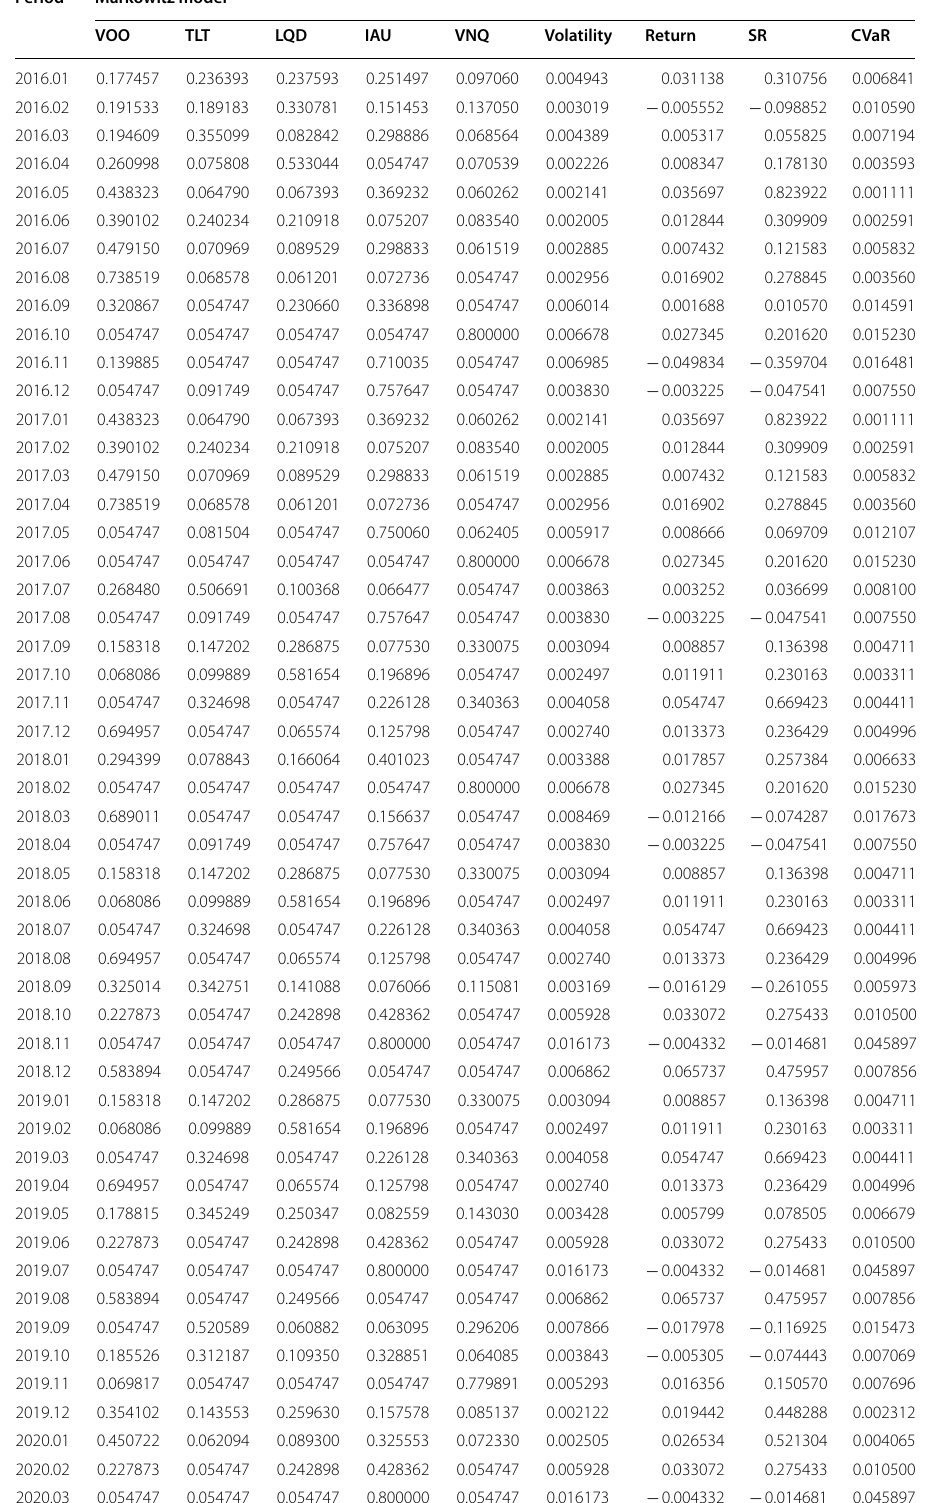
Table 6 The out‑of‑sample results of Markowitz model and semiparametric method with CVaR